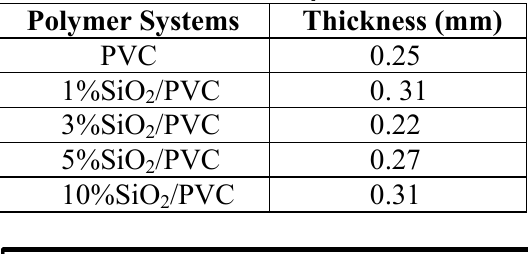
Table 1: Thicknesses of samples.